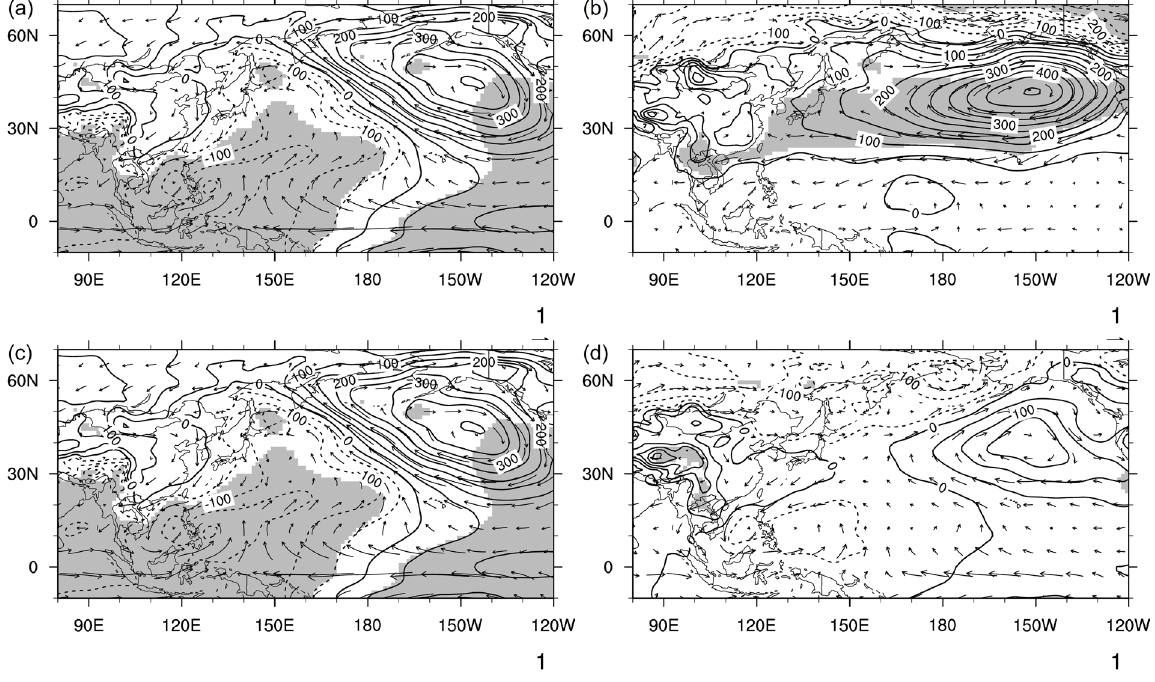
Figure 8. Spatial patterns of composite differences between positive and negative phases of ( a ) the El Niño-Southern Oscillation (ENSO) related part and ( b ) the unrelated part of PC1pri-res; ( c ) and ( d ) are the same as (a) and (b), but for PC1sec-res. The vector and contour line are the differences of wind (meters per second) and sea level pressure (hectopascals), respectively, and the shading contour is the 0.05 significance